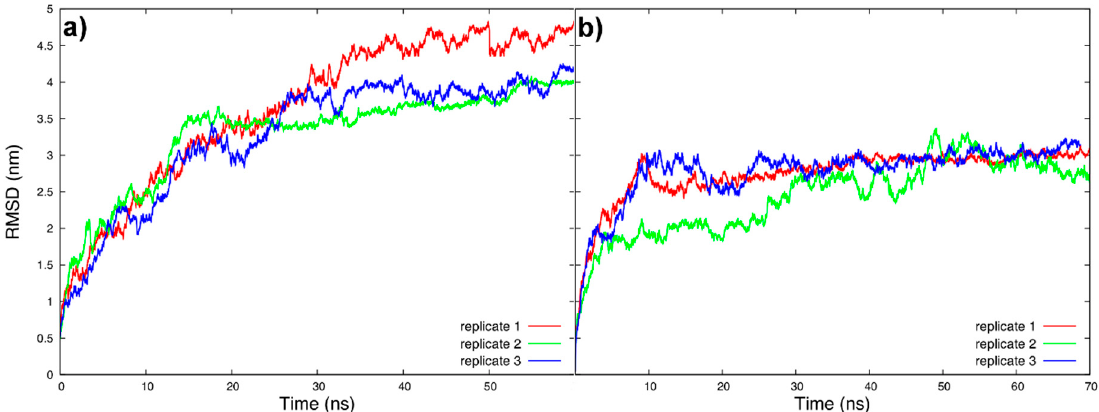
Figure 5. Backbone root-mean-square deviation (RMSD) of tau, fitting the backbone, for all tau replicates ( a ) in fluid and ( b ) when associated with microtubule, from the initial predicted model.